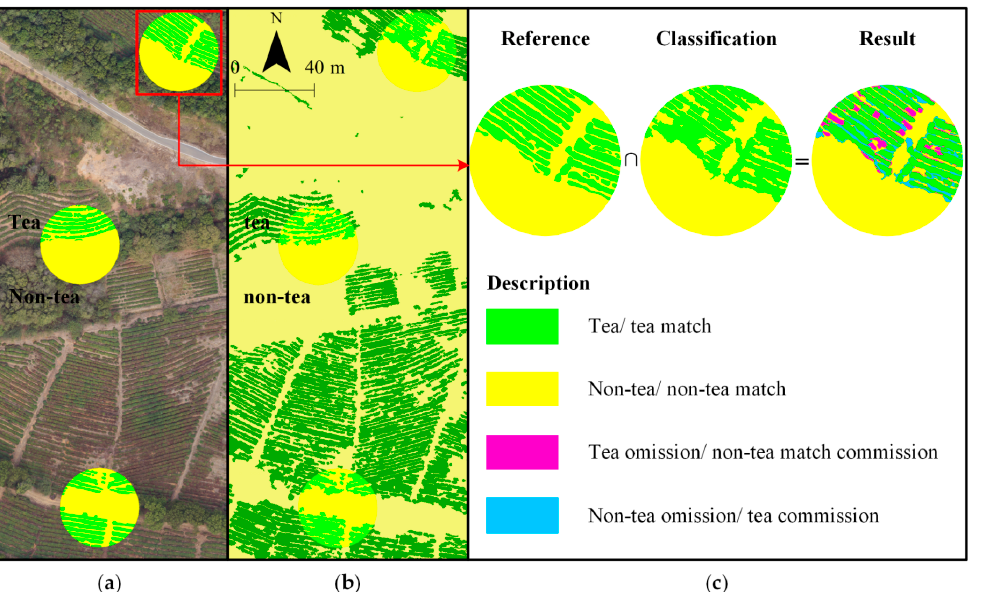
Figure 5. Illustration of the tea and non-tea area-based accuracy assessment: ( a ) digital imagery with a spatial resolution of 0.1 m; ( b ) thematic map produced using the random forest algorithm; ( c ) the classes produced from the area intersection process. Table 3. Area-based accuracy assessment equations.